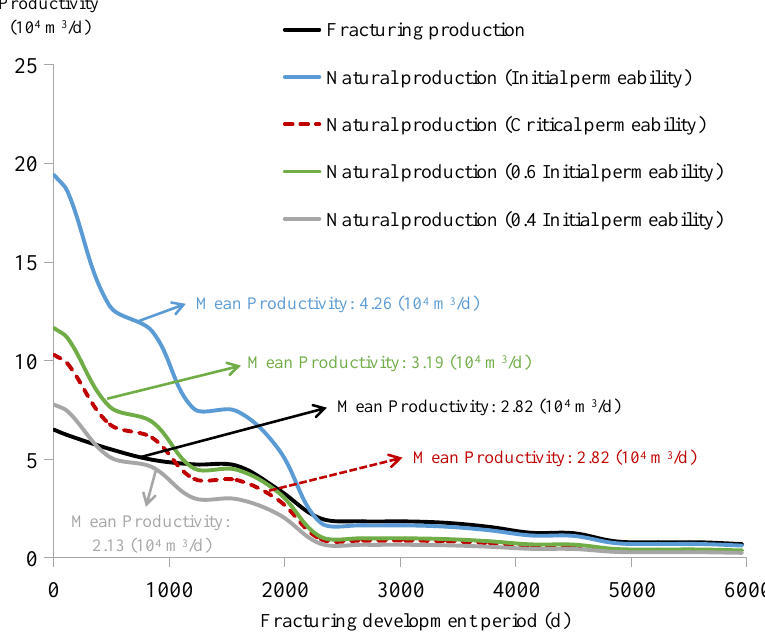
Figure 12. Critical permeability for natural development rather than fracturing.